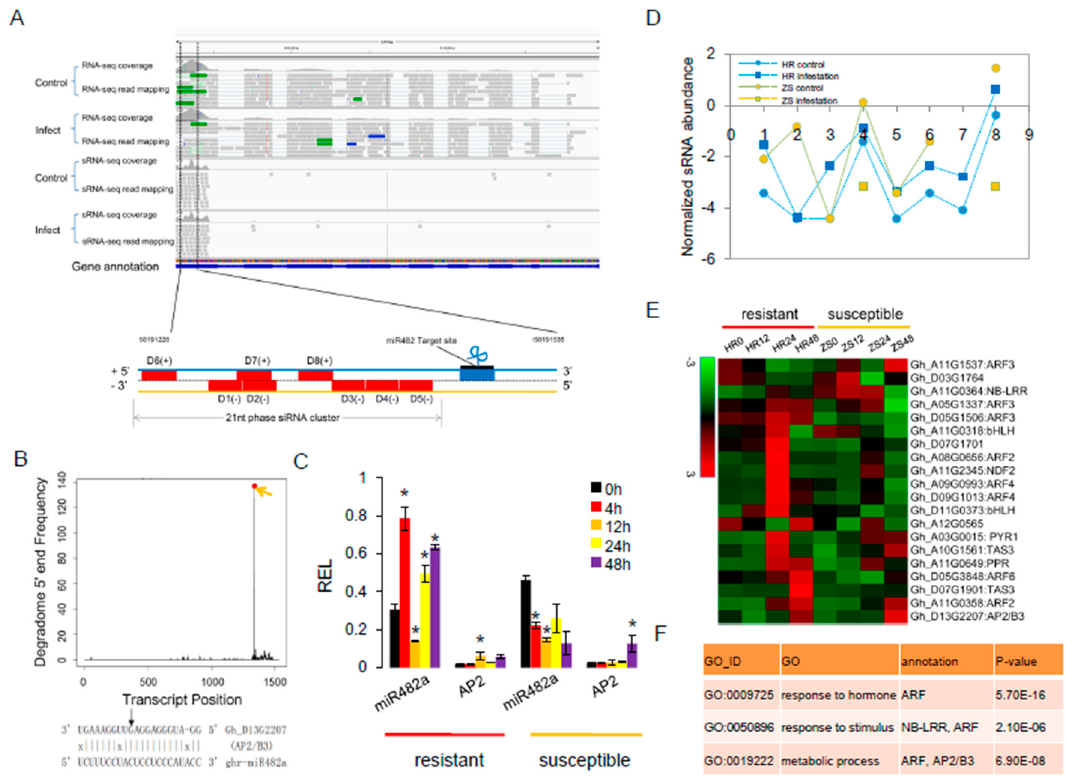
Figure 6. The miRNA-mediated phasiRNA pathway involved in the cotton response to whitefly infestation. ( A ) Integrative Genomics Viewer (IGV) depiction of miR482a-mediated cleavage of the AP2 / B3 transcription factors and the resulting 21-nt phasiRNAs. The schematic diagram depicts the secondary siRNA biogenesis that is initiated at the 5'-target site. ( B ) Degradome data showing miRNA-guided target cleavage sites. ( C ) Expression profile of miR482a in HR and ZS plants following whitefly infestation. Three biological replicates were assayed for each control and the whitefly-infested samples (Student’s t-test * p < 0.05). ( D ) siRNA abundance profile from the phased region. ( E ) Expression profile of phasiRNA targets in HR and ZS plants following whitefly infestation. ( F ) GO enrichment analysis of phasiRNA target genes ( p < 0.01).